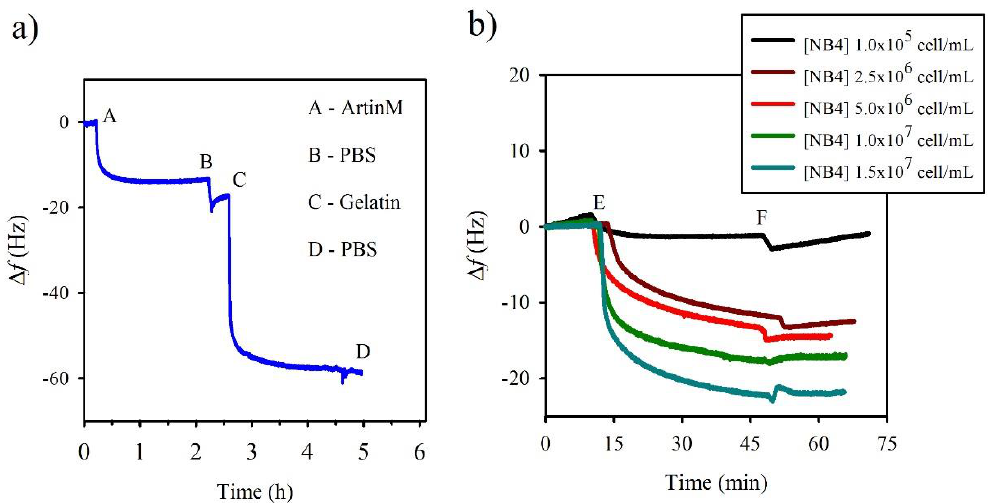
Figure 3. Determination of the ArtinM–NB4 interaction by QCM. ( a ) Real-time frequency shifts ( 𝛥𝑓 ) shown as a function of measured time of adsorption of lectin by ArtinM: (A) the initial moment of ArtinM injection, (B) injection of PBS to wash the crystals, (C) injection of gelatin to block non-occupied sites, (D) re-injection of PBS for washing the non-adsorbed gelatin. ( b ) Real-time frequency shifts as a function of time for ArtinM interacting with different concentrations of NB4 cells: (E) initial moment of cell injection, (F) injection of PBS. The final values correspond to the frequency shift due to specific binding between the cells and